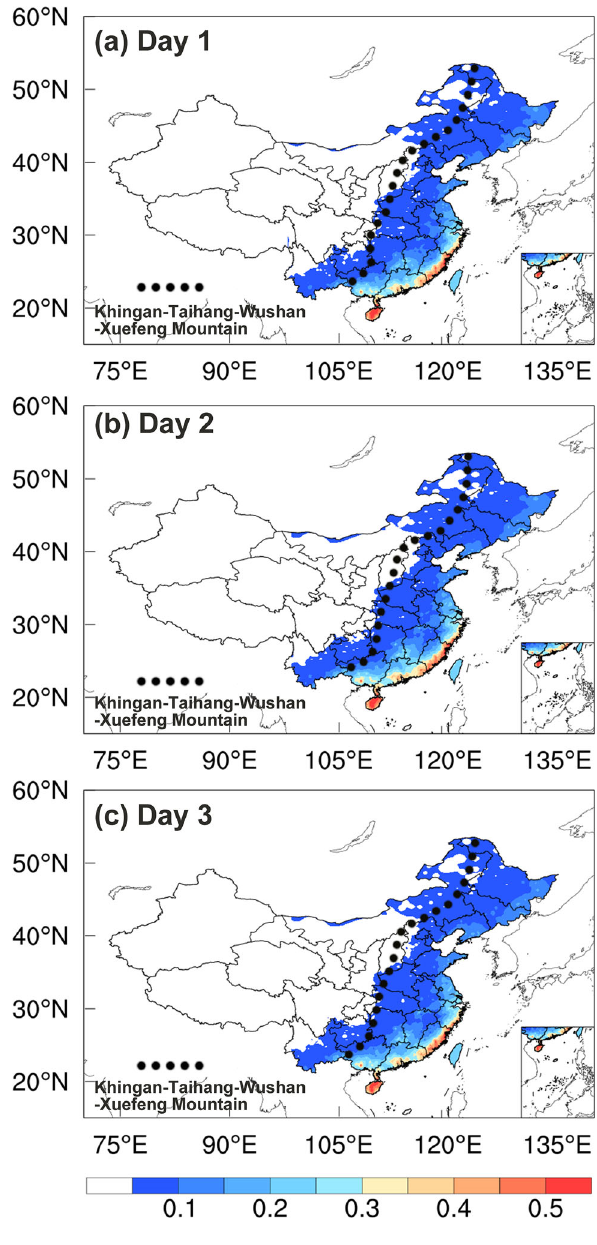
Fig. 3 Contributions of tropical cyclones (TCs) to annual maximum (AM) 1-day (Day 1) ( a ), 2-day (Day 2) ( b ), and 3-day (Day 3) ( c ) precipitation in the mainland of